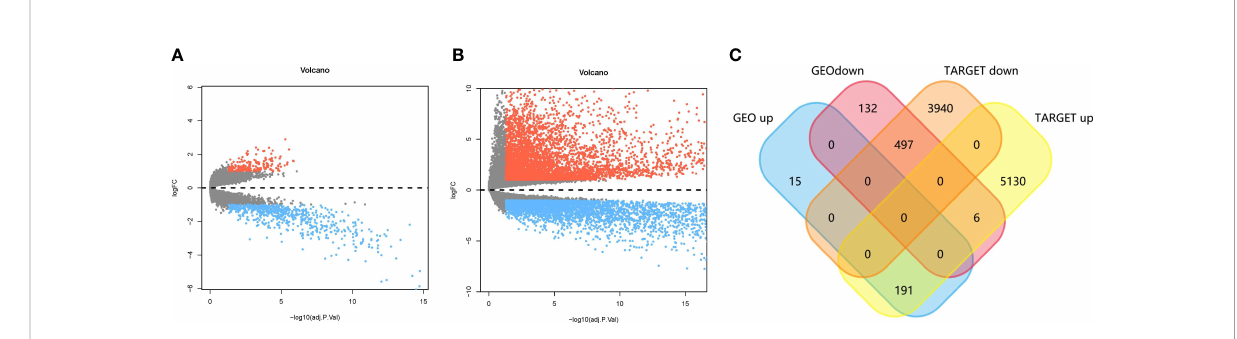
FIGURE 1 (A) and (B) Volcano plot of differentially expressed genes of Wilms tumor patients from GEO and TARGET database. Genes with P < 0.05 and logFC >1 or <-1 were considered as DEGs in each series. Blue, down-regulated genes; Gray, non-differential genes; Red, up-regulated genes (C) Venn diagram showing the intersection of the DEGs identi fi ed in two